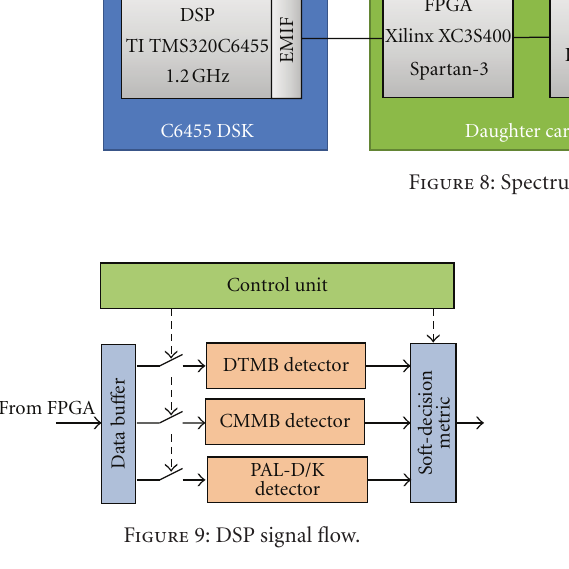
Figure 9: DSP signal flow.